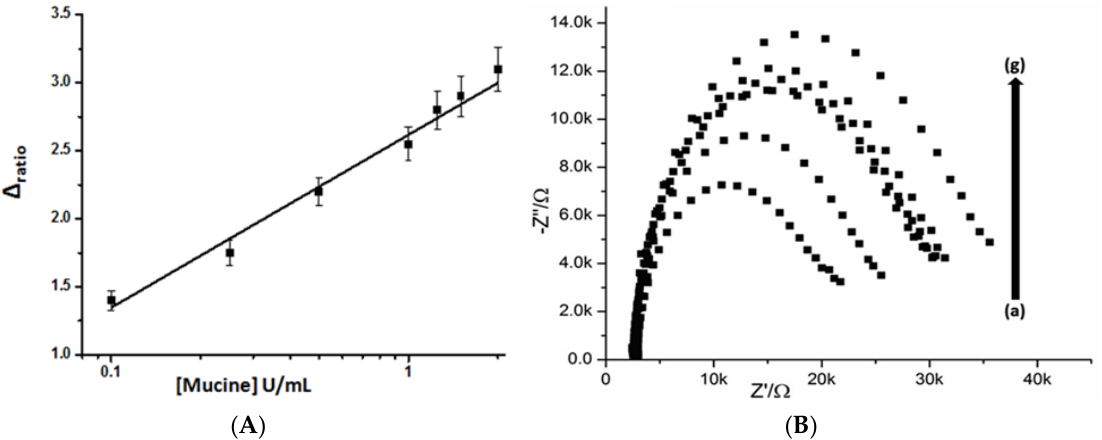
Figure 6. The calibration curve corresponding to the detection of mucine based on changes of electron-transfer resistance (Ret), which presented as ∆ ratio ( A ) Nyquist plots of mucine-aptamer modified SPCEs with different concentrations of mucine U/ml (a) 0.1 (b) 0.25 (c) 0.5 (d) 1 (e) 1.25 (f) 1.5 and (g) 2 ( B ). Table 1. Analytical performance of the proposed aptasensor with the previously reported electrochemical sensors for detection of MUC1 . Sr. No